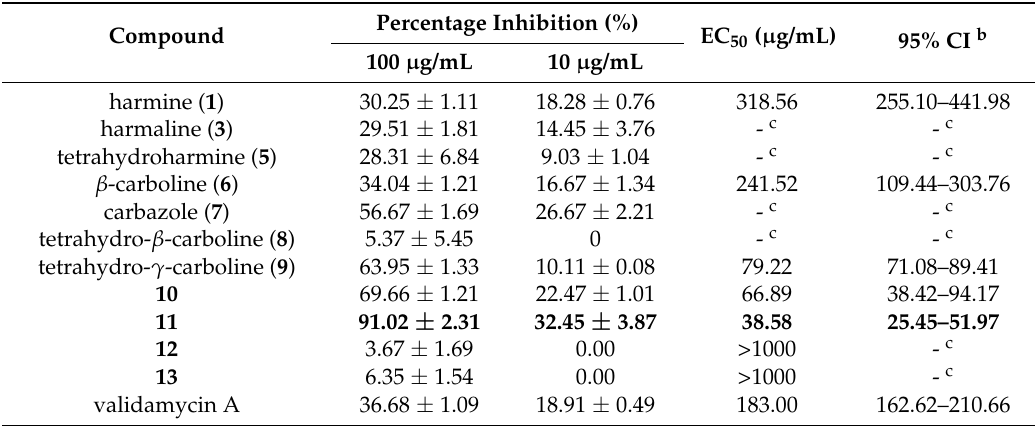
Table 1. In vitro fungicidal activity of compounds 1 , 3 , and 5 – 13 .